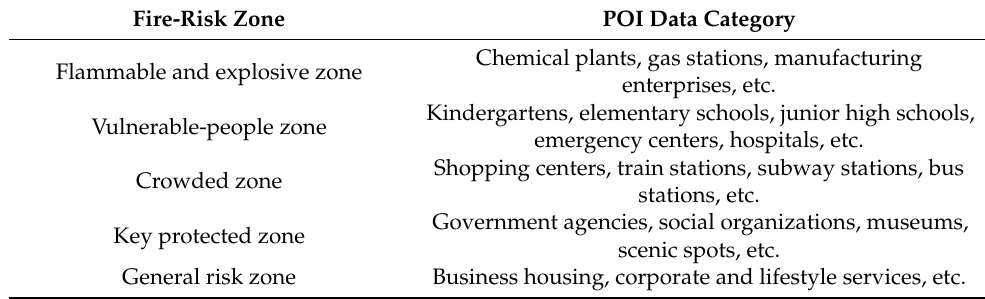
Table 1. POI data classification